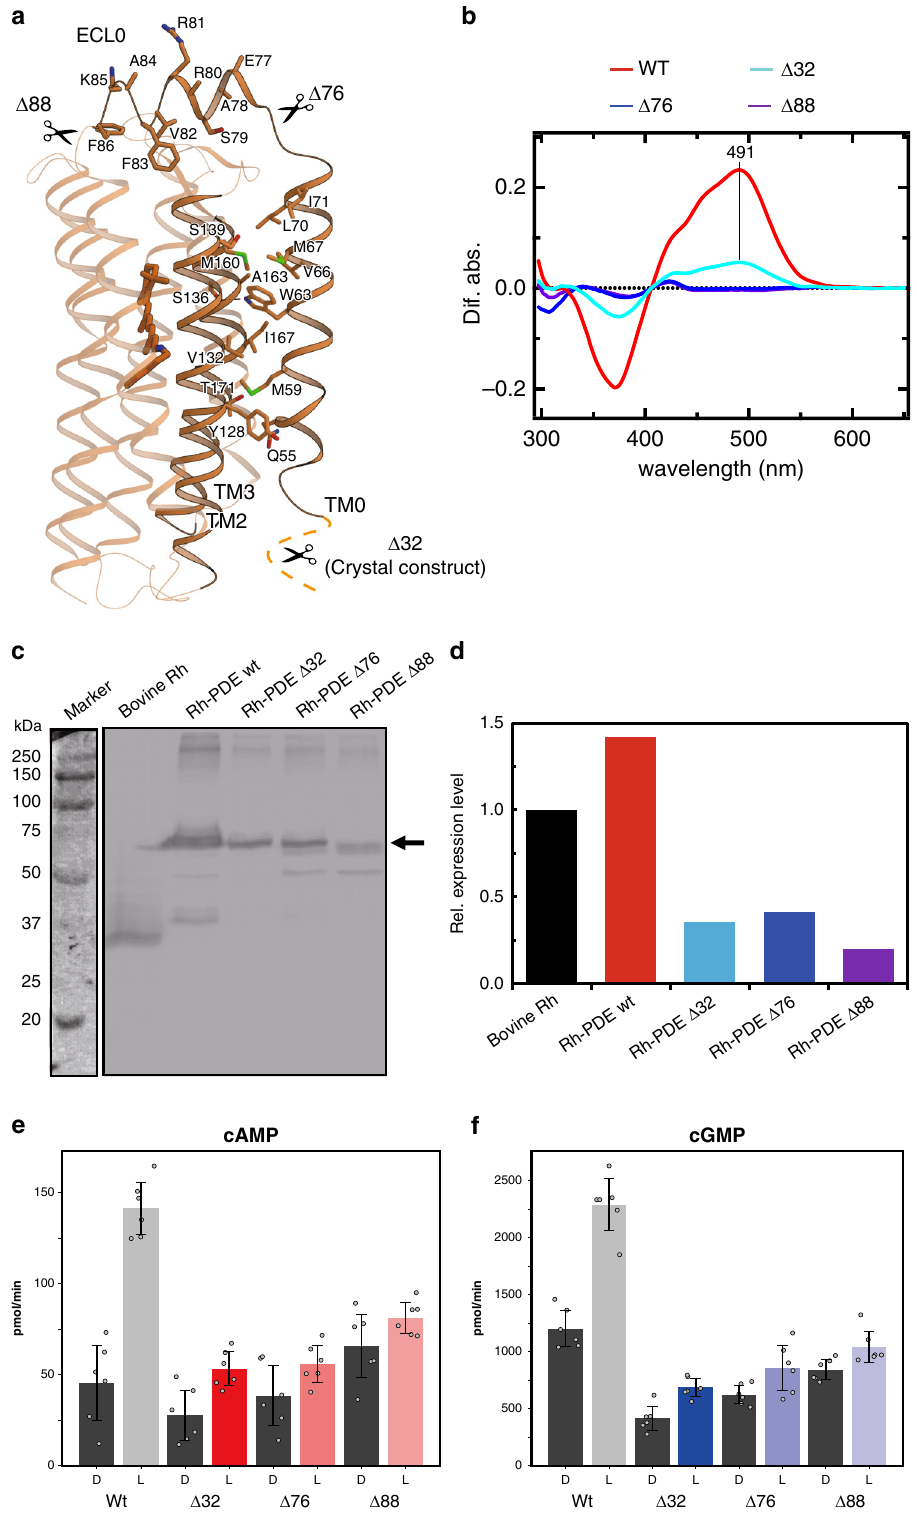
Fig. 3 Structure and function of TM0. a Residues at the interface between TM0 and the rhodopsin domain. b Absorption spectrum with hydroxylamine bleach of the N-terminal truncated mutants. c Representative immunoblots indicating expression levels of bovine Rh (~35 kDa), Rh-PDE wt (~75 kDa), Rh- PDE Δ 32 (~72 kDa), Rh-PDE Δ 76 (~67 kDa), and Rh-PDE Δ 88 (~65 kDa) in detergent solubilized fraction isolated from HEK293T cells and detected with the anti-Rho C-terminal 1D4-tag antibody. Source data are provided as a Source Data fi le. d Band intensities in ( c ) were quanti fi ed and calculated the relative expression level against to bovine Rh obtained with imageJ software ( n = 1). e , f Photoactivities of truncated mutants with cAMP ( e ) and cGMP ( f ). Data are presented as mean values ± standard deviation (SD) ( n = 6 independent